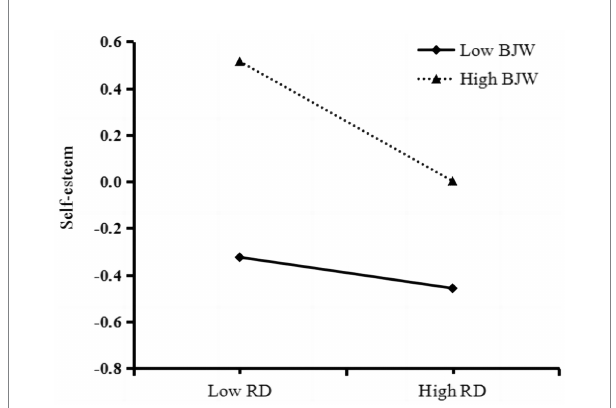
FIGURE 5 Robustness test: The moderating effect of relative deprivation on the prediction of self-esteem. RD, relative deprivation; BJW, belief in a just